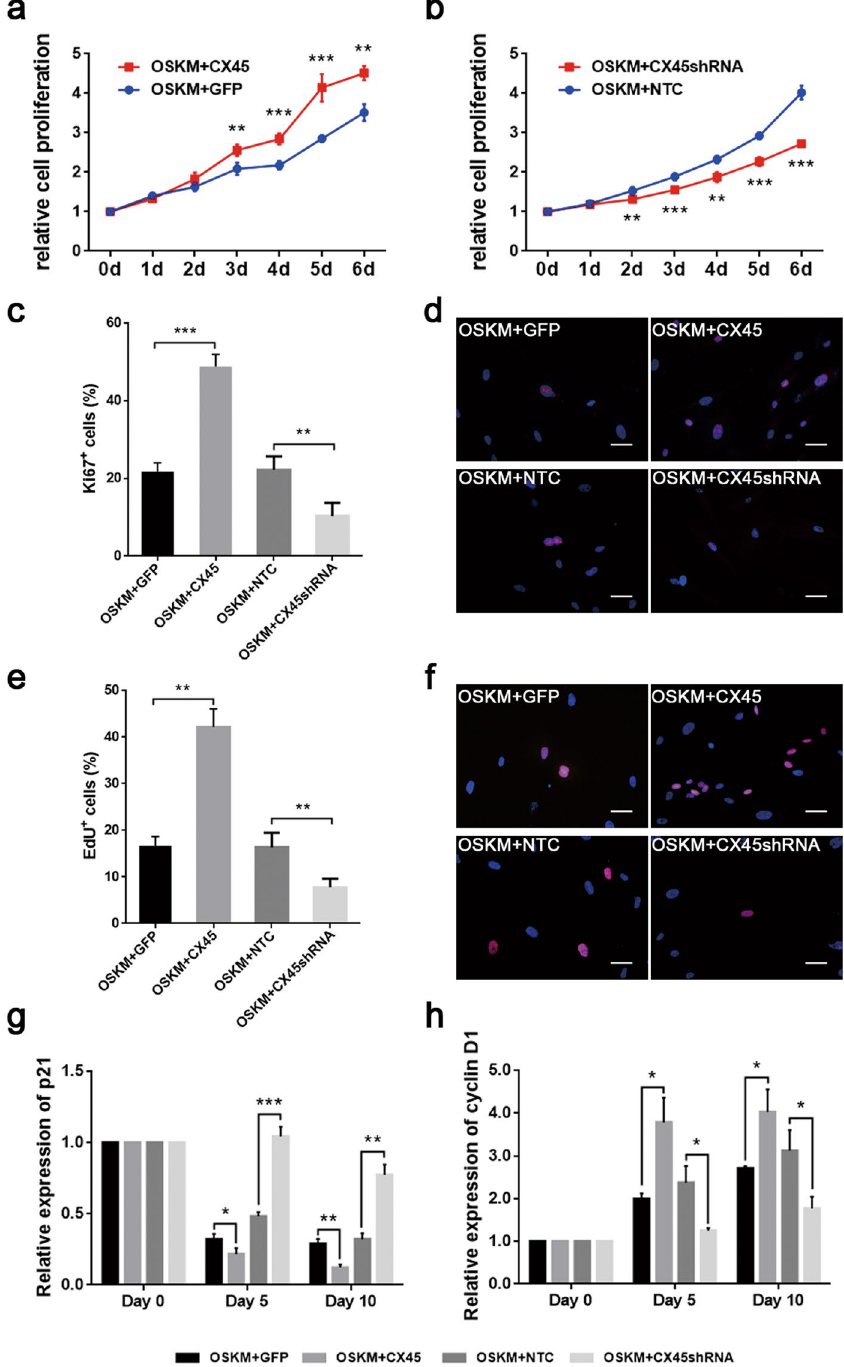
Figure 4. CX45 overexpression or knockdown affected the cell proliferation. ( a , b ) Cell proliferation on the indicated days was tested by CCK8 kit. Absorbance values of wells in day 0 were arbitrarily assigned a value of 1.0. ( c ) Percentage of proliferating cells (Ki67 + cells) out of total population. ( d ) Fluorescence micrographs show Ki67 + cells (red) in each group; the nuclei were visualised with DAPI staining (blue). ( e ) Percentage of proliferating cells (EdU + cells) out of total population. ( f ) Fluorescence micrographs show EdU + cells (red) in each group; the nuclei were visualised with DAPI staining (blue). ( g and h ) Real-time PCR analysis to detect the expression levels of p21 and cyclin D1 genes. Expression was normalized to GAPDH and gene expression on day 0 was arbitrarily assigned a value of 1.0. The data are presented as the mean ± S.E.M. (n = 3) and are representative of three independent experiments. * P < 0.05, ** P < 0.01, *** P < 0.001 versus OSKM + GFP or OSKM + NTC group. OSKM + GFP, eGFP expression vector plus OSKM; OSKM + CX45, CX45 expression vector plus OSKM; OSKM + NTC, containing nonspecific shRNA plus OSKM; OSKM + CX45shRNA, containing CX45 shRNA target sequences plus